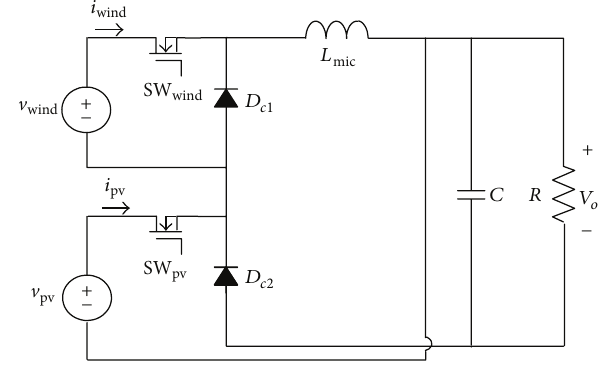
Figure 2: An illustration of double-input buck-boost converter.